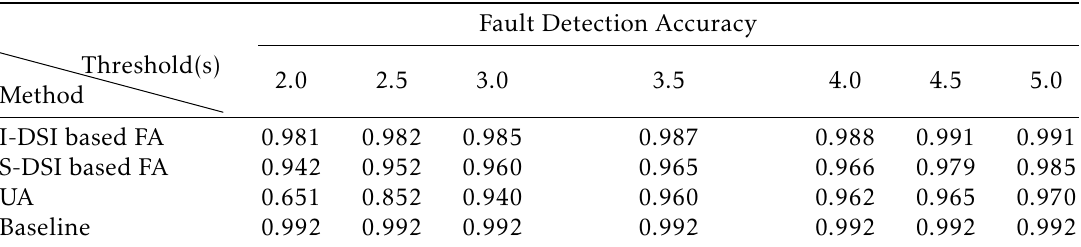
Table 7. Effect of latency limit as well as overall interaction data transfer on the FA schemes along with MNIST.